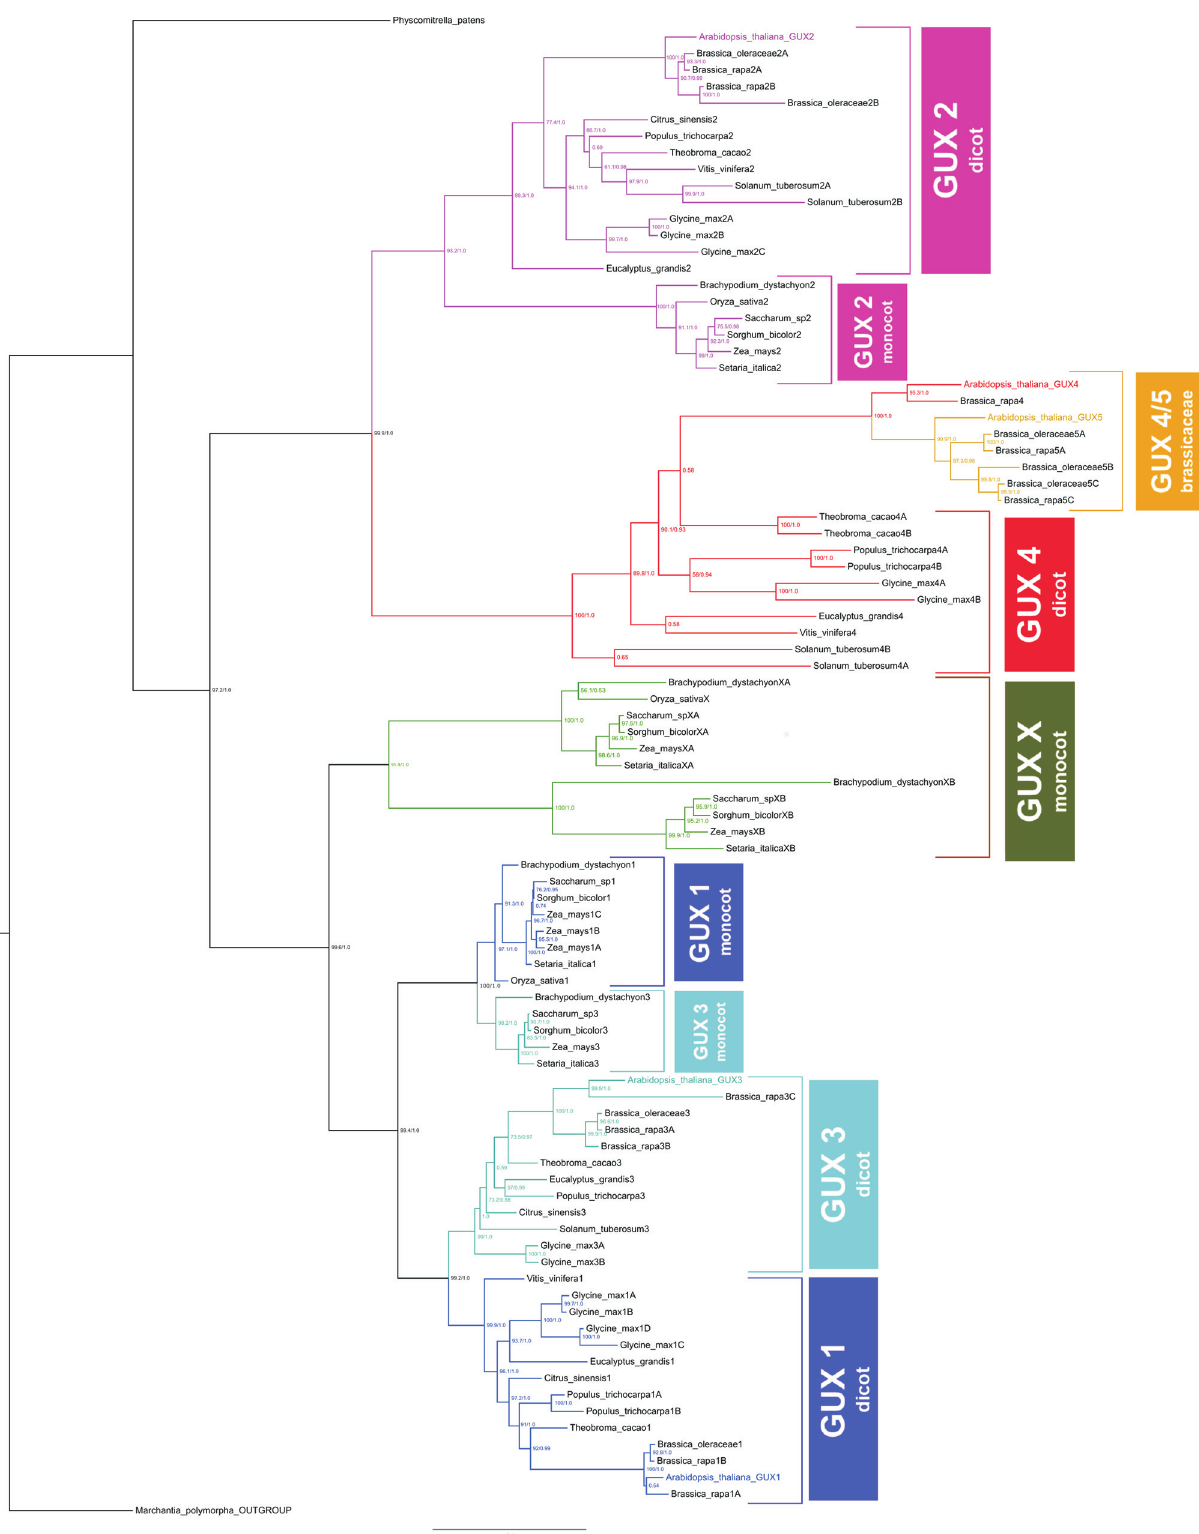
Figure1 -PhylogenetictreeofGUXproteinsinplants.Numbersonnodescorrespondtothemaximumlikelihood(ML)ultrafastbootstrapsupportvalues followedbyBayesianposteriorprobabilities.Thecoloredbranchesarerepresentedby:GUX1(darkblue),GUX2(pink),GUX3(lightblue),GUX4(red), GUX4/5 (yellow) and GUX ‘X’ (green). The GUX sequence from Marchantya polymorpha was used as the